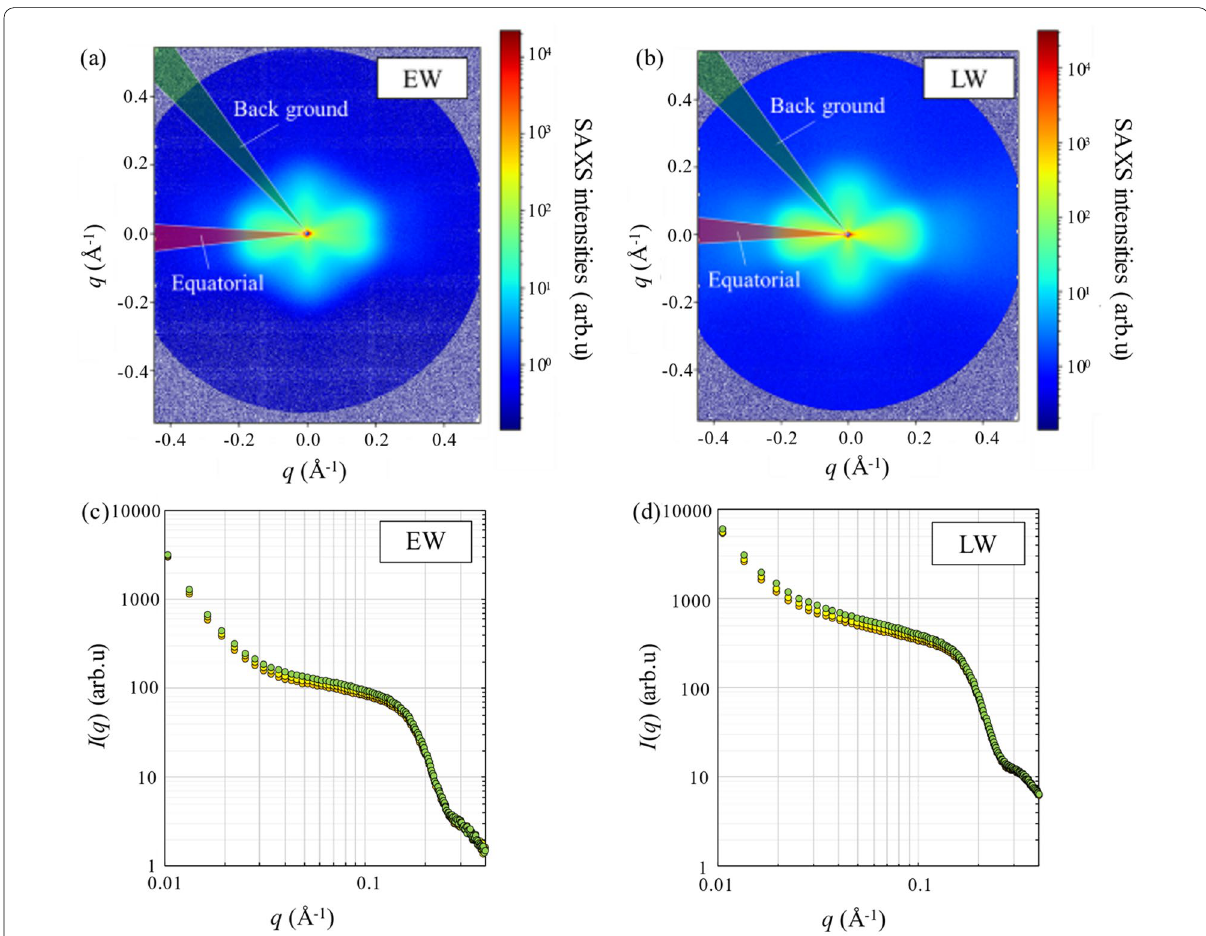
Fig. 6 Representative SAXS data from Douglas fir swollen by water. a , b The SAXS pattern of earlywood ( a ) and latewood ( b ) in water at 25 ℃ , measured at 1.0 m sample-to-detector distance and with the fiber axis vertical. The azimuth ranges for the azimuthal integration at the equator and the background were overlaid on the scattering pattern. c , d Background-subtracted q - I plots for water-saturated earlywood ( c ) and latewood ( d ) in water at 25 ℃ (orange filled circles), 60 ℃ (yellow filled circles), and 90 ℃ (green filled